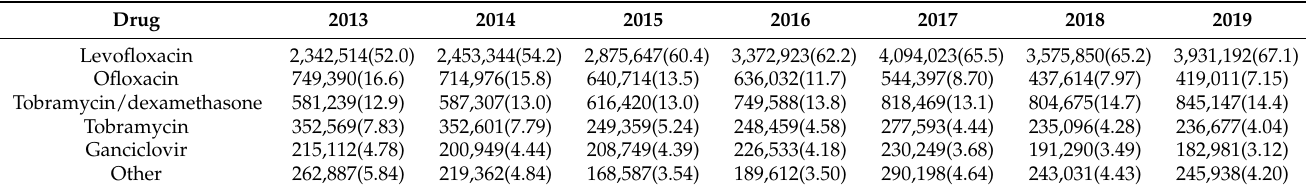
Table 3. Expenditure on ocular topical anti-infectives dispensed from 2013 to 2019 1 .